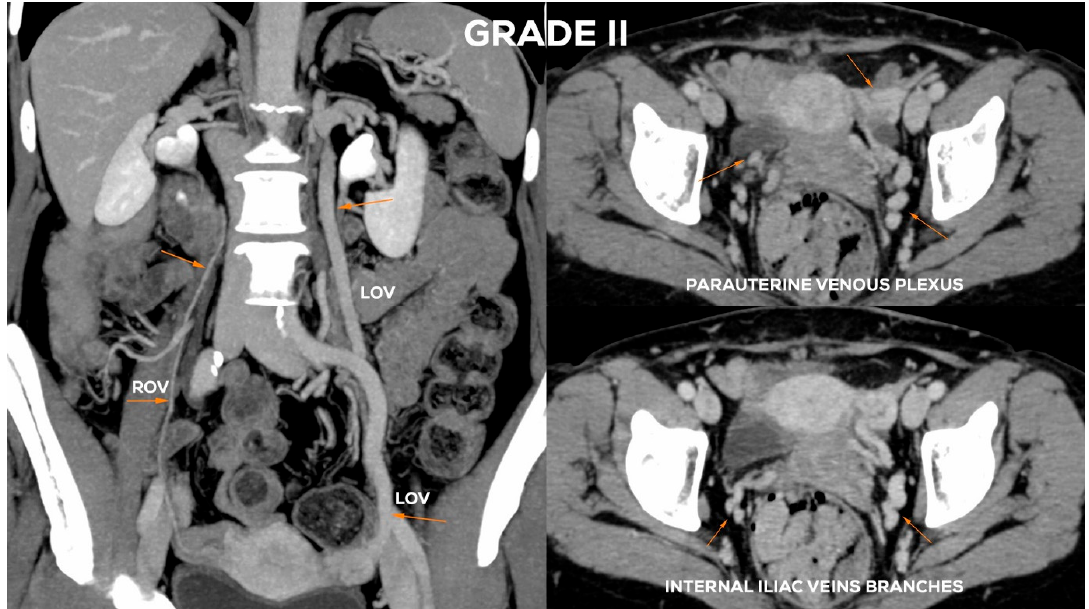
Figure 12. Typical findings in patient with Grade II ovarian veins insufficiency seen on a CTV images in coronal and axial planes.